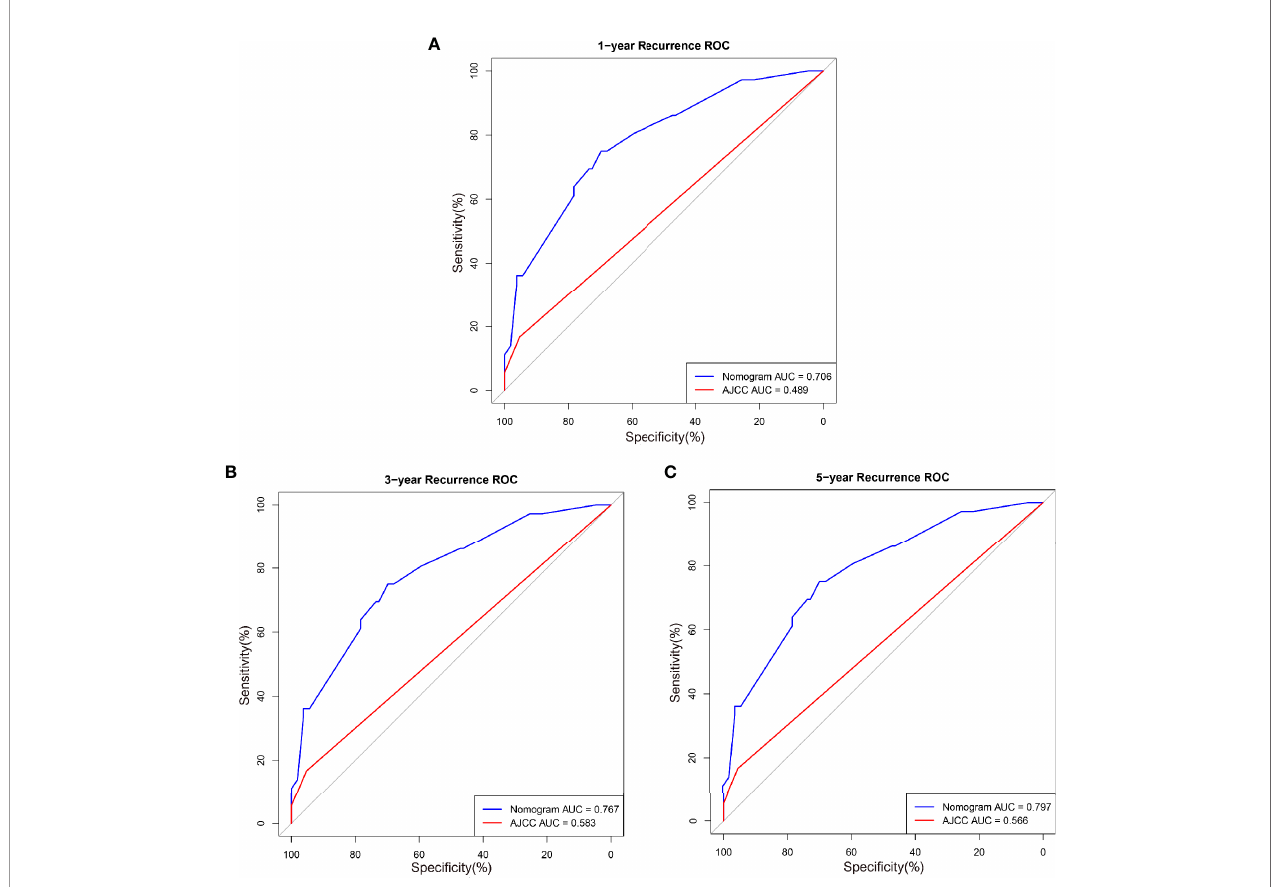
FIGURE 5 | ROC curves comparing the effectiveness of predicting (A) 1-, (B) 3-, and (C) 5-year IV-RFS between the nomogram and the American Joint Commission on Cancer (AJCC) score in the training cohort. Nomogram-predicted intravesical recurrence-free survival rates are indicated by the blue lines, and AJCC-predicted overall survival rates are indicated by the red